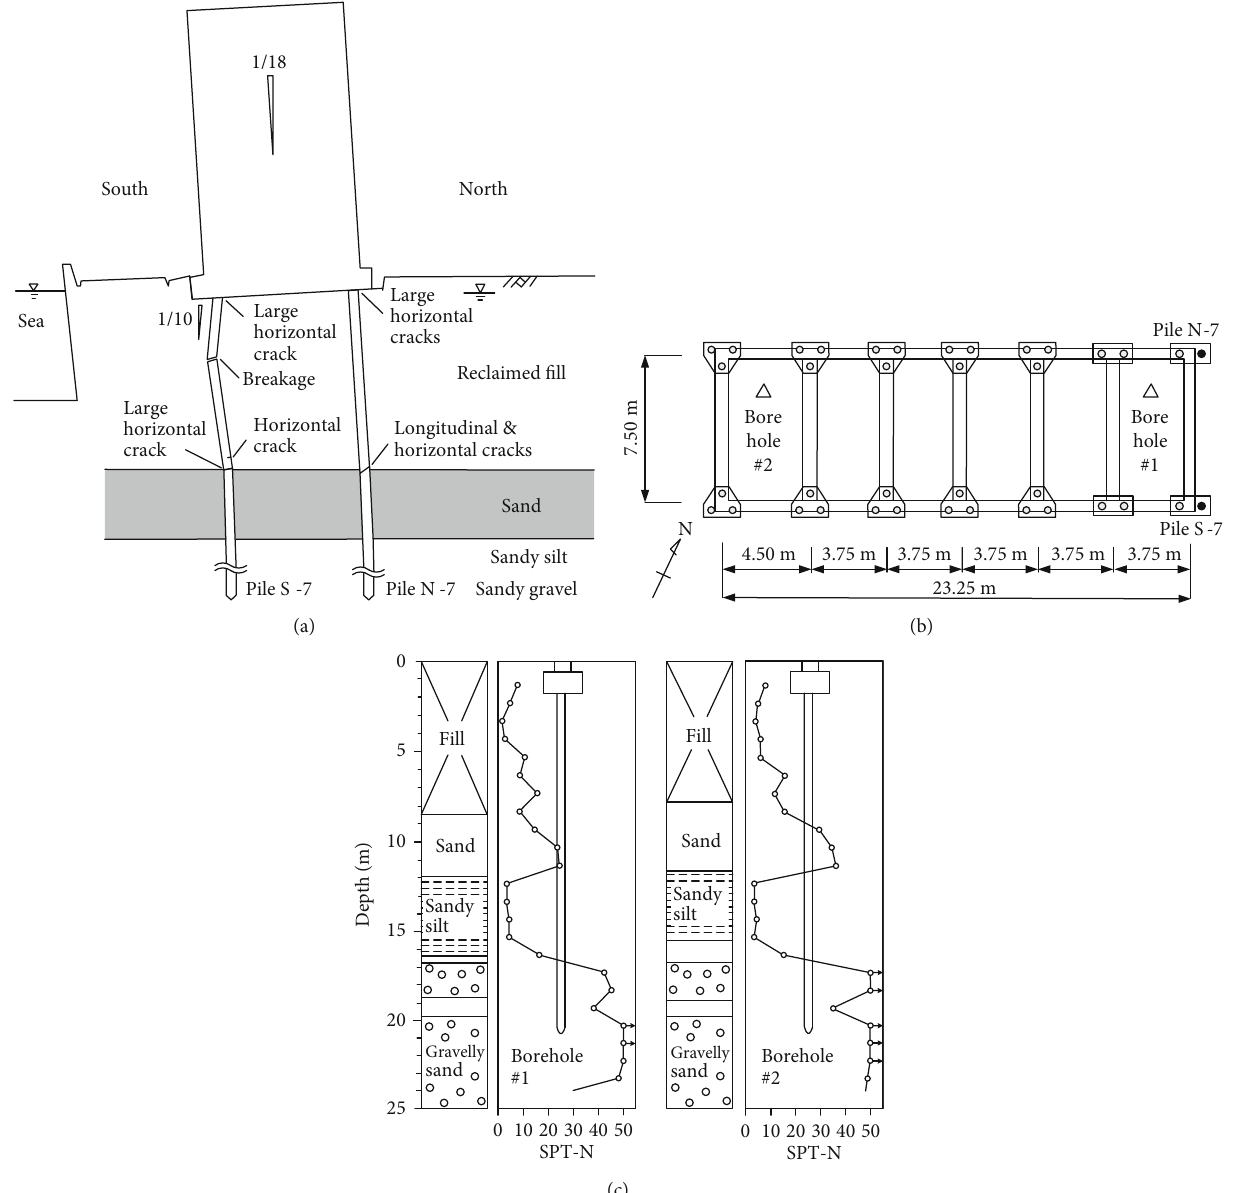
Figure 3: A building near waterfront su ff ered pile damage during the 1995 Kobe Earthquake. (a) Tilt of the building and damages along piles. (b) Foundation layout. (c) Boring log of the site. (After